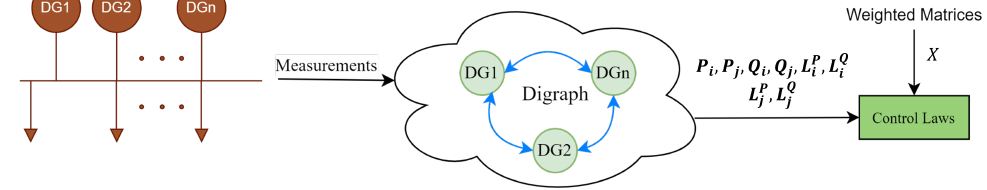
Figure 7. Implemented multi-layer communication strategy based on the vector parameter X to adjust the system’s